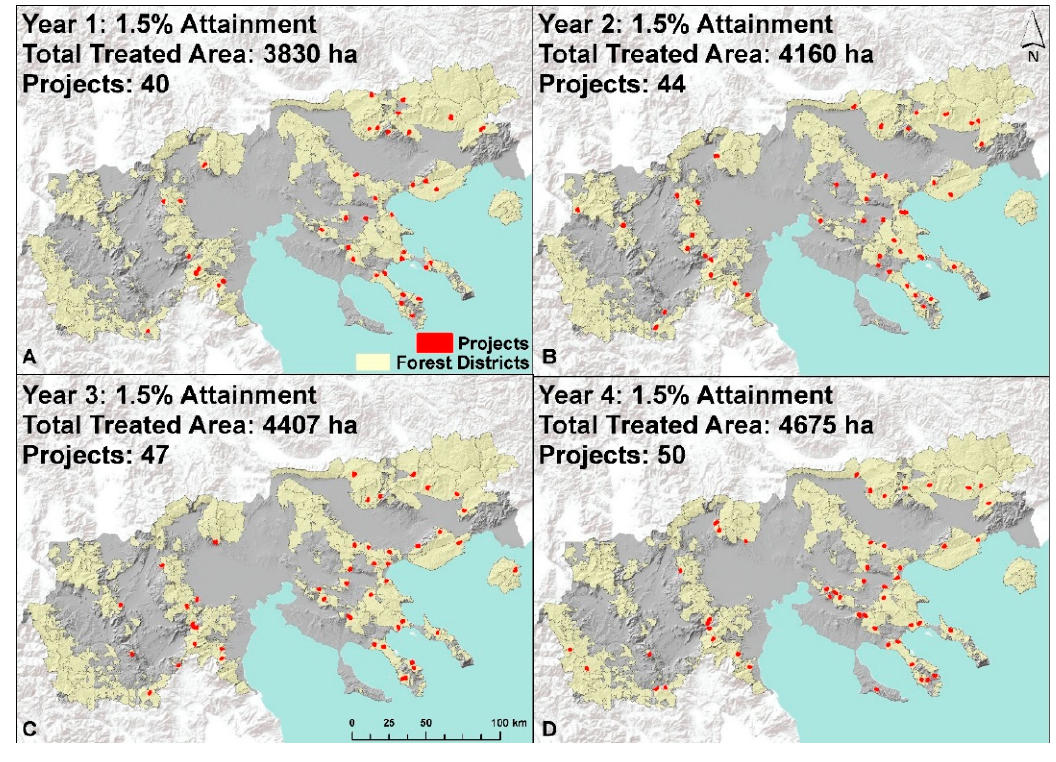
Figure A4. Annual fuel treatment locations of the best 100-hectare projects for a four-year period, as estimated from the prioritization of suppression difficulty.